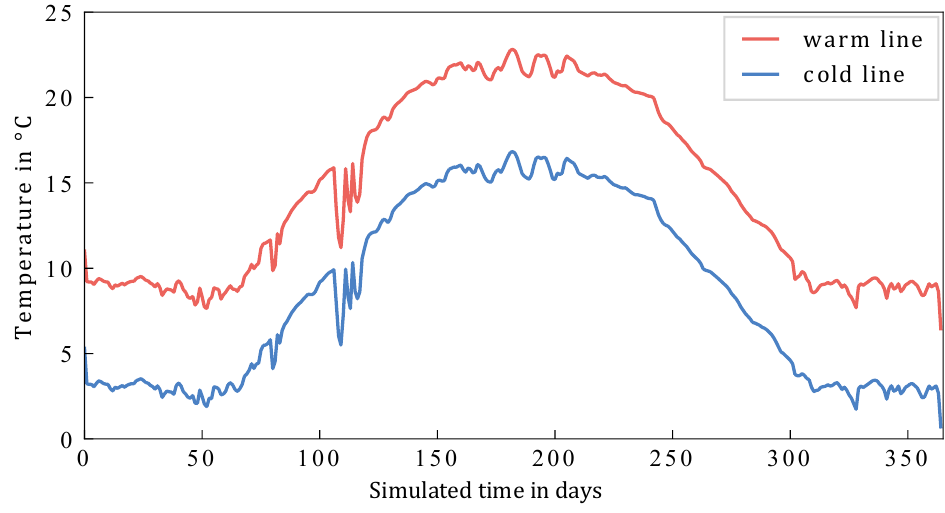
Figure 18. Temperature of warm and cold line at cluster C9